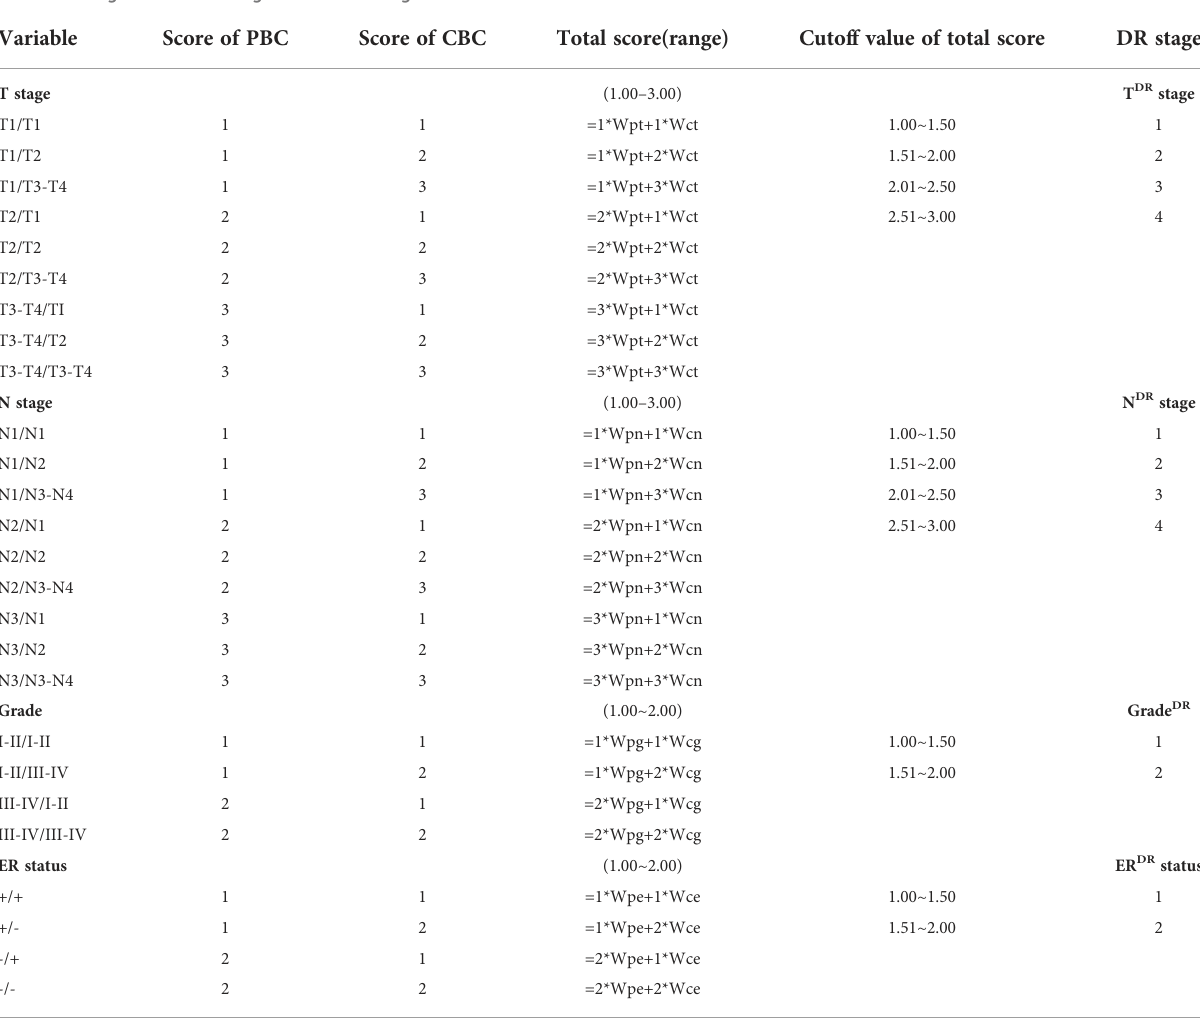
TABLE 2 Prognostic score assignment and DR